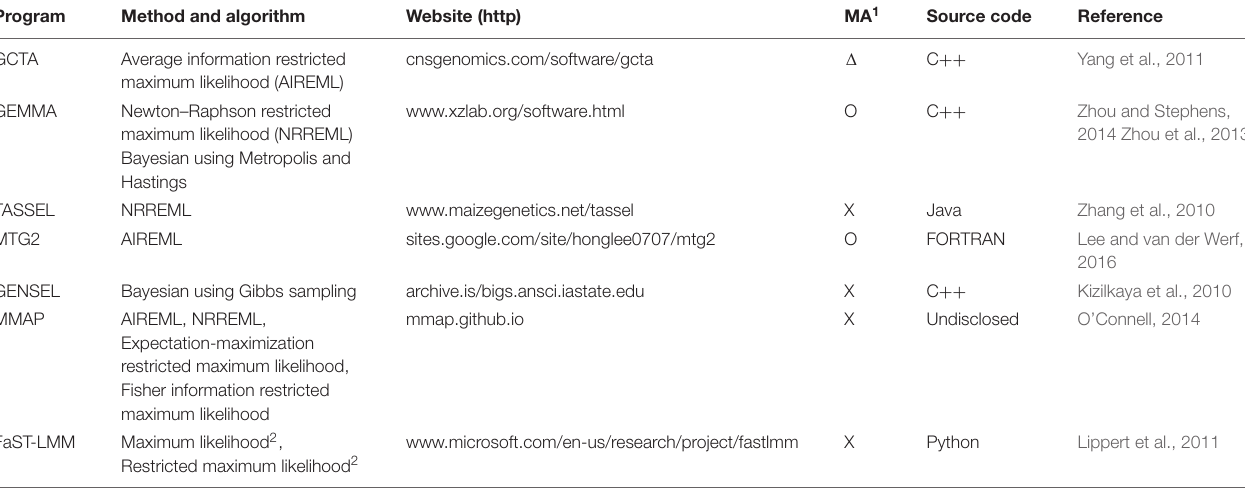
TABLE 2 | Useful software for genome-wide eQTL analysis using mixed models.